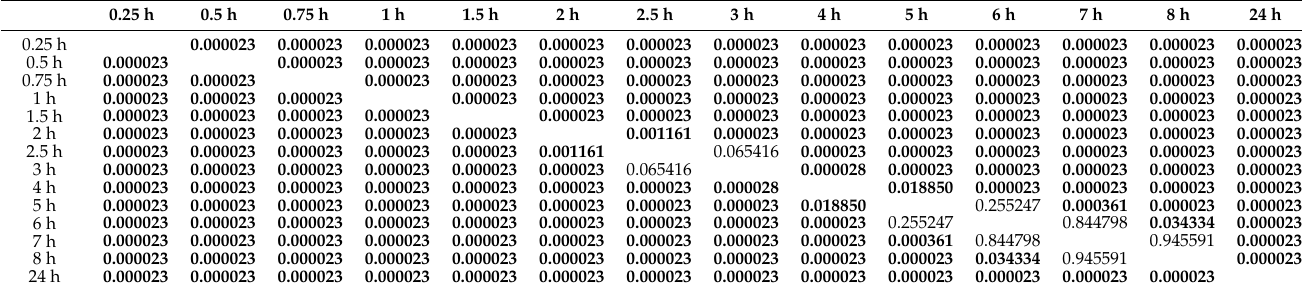
Table A6. Significant differences for the EMC variable for the effect of climatic chamber operation time (CCOT) according to Tukey’s test (HSD) for grapefruit peels.